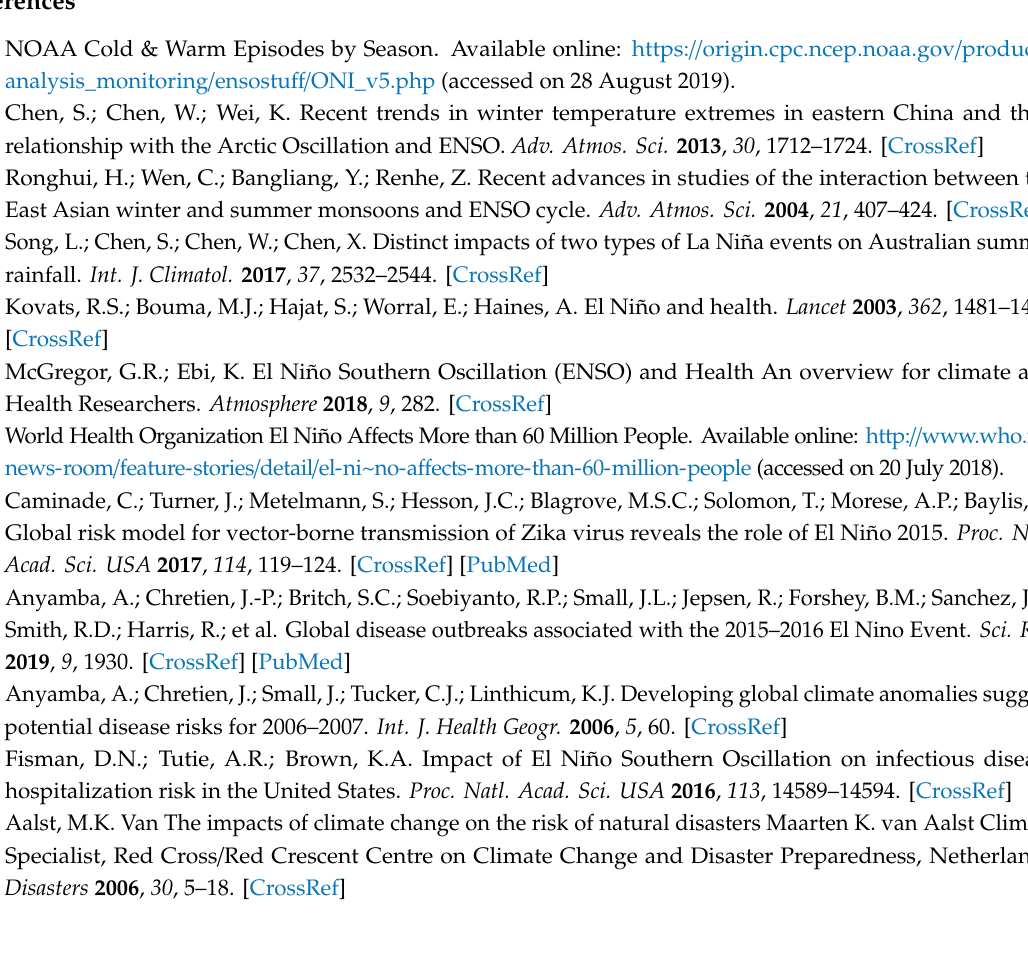
Figure A3. RR-DJF / RR-DJ plots for the association between PAD rate for flood and ONI(DJF) / MEI (DJ) Figure A3. RR-DJF/RR-DJ plots for the association between PAD rate for flood and ONI(DJF)/MEI in Philippines and India. Yearly data from NOAA and EMDAT, (DJ) in Philippines and India. Yearly data from NOAA and EMDAT, 1964–2017.